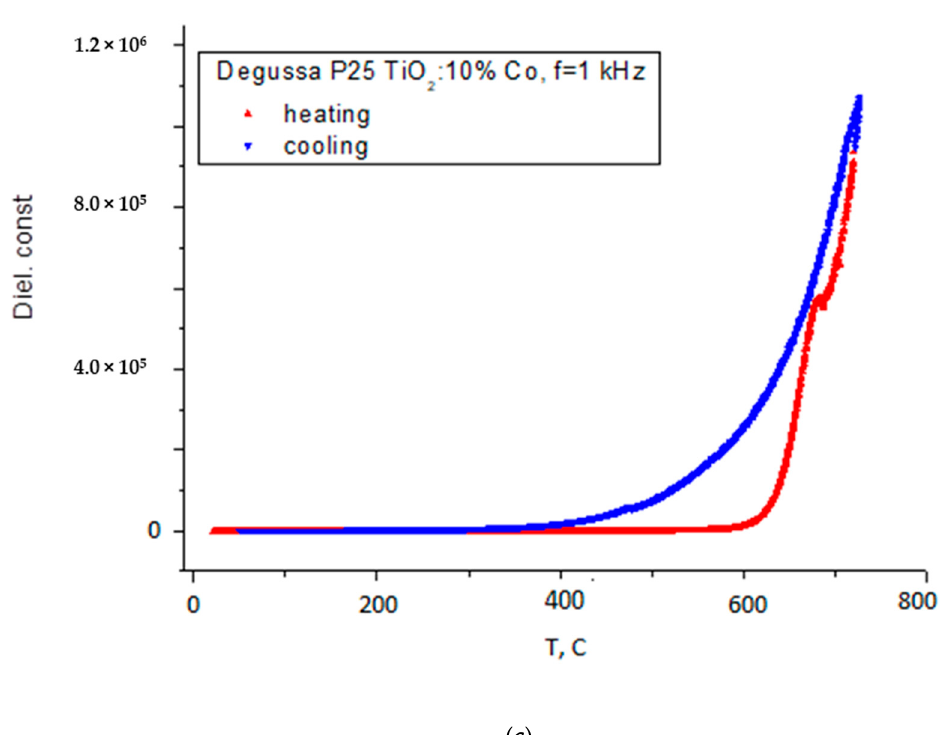
Figure 5. ( a ) Dielectric constant of pure anatase TiO 2 sample prepared by Sol-Gel method. ( b ) Dielectric constant of Degussa P25 TiO 2 sample doped with 2% Co. ( c ) Dielectric constant of Degussa P25 TiO 2 sample doped with 10% Co.